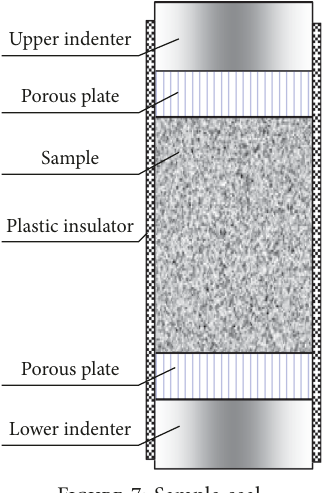
Figure 7: Sample seal.